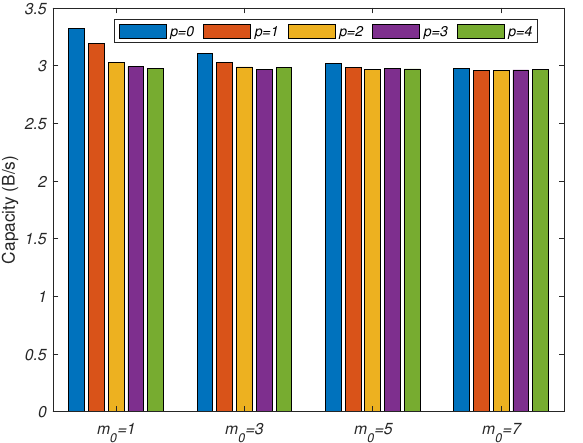
Figure 9. Information capacity of OAM channels versus topological charge number m 0 and PLGs p